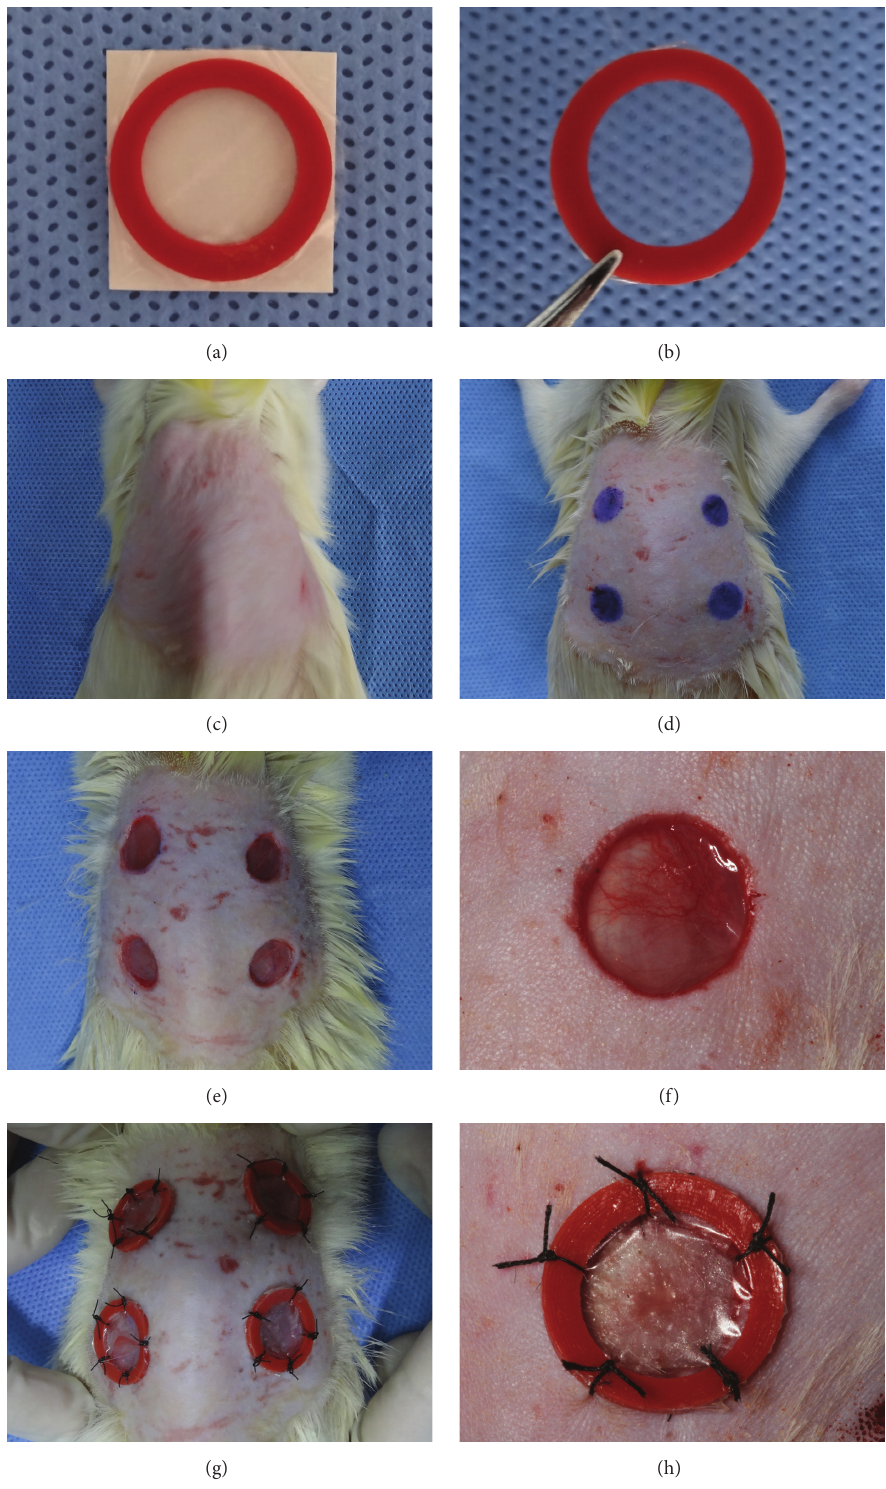
Figure 1: Procedures of creating wounds and securing silicone splints and “Tegaderm”: (a) glue the silicone splint to the “Tegaderm” inner surface; (b) clip the silicone splint with the “Tegaderm” layer together; (c) treat the rat with conventional anesthetization, skin preparation and sterilization, then put it in ventral recumbency; (d) measure and locate the wounds with the shaped rubber stamp inked with gentian violet; (e) create four full-thickness wounds on the rat dorsum; (f) gross appearance of single wound; (g) suture the silicone splint with “Tegaderm” together; (h) gross appearance of single wound covered with silicone splint and “Tegaderm” sutured